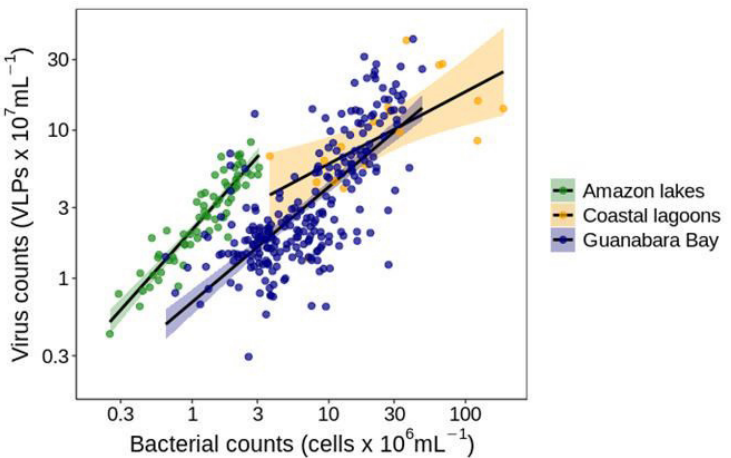
Figure 5. Regression between viruses and bacterial counts from water samples collected in Brazilian aquatic ecosystems. The strong positive relationships (Amazon lakes: n = 66, r 2 = 0.84, p <0.01; Coastal lagoons: n = 18, r 2 = 0.39; p <0.01; Guanabara Bay: n = 246, r 2 = 0.53; p <0.01) indicate that high bacterial abundances are generally followed by a greater number of viral particles. The literature data were obtained from Barros et al. (2010) (Amazon lakes), Almeida et al. (2015) (Amazon lakes), Cabral et al. (2017) (Guanabara Bay) and Junger et al. (2018) (coastal lagoons in the state of Rio de